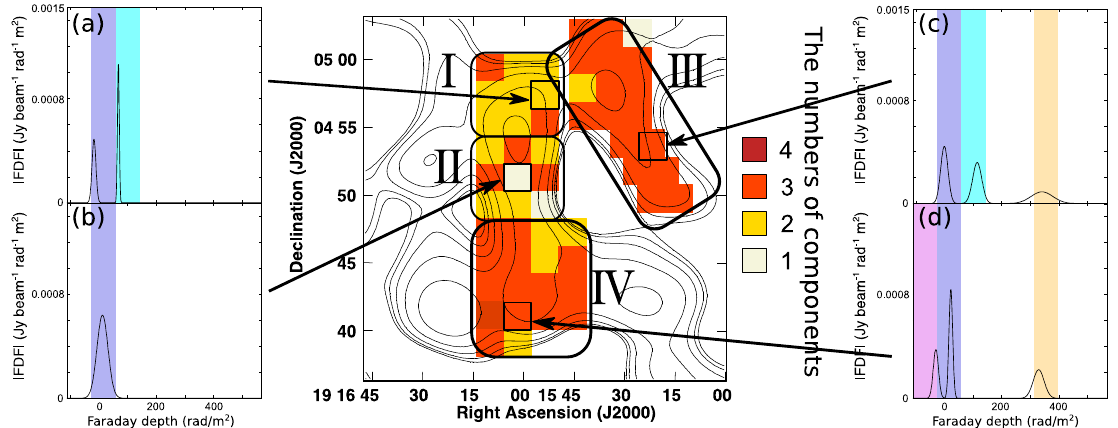
Figure 3. ( Middle panel ) The number of Gaussian components in the selected best-fit model for each pixel, as obtained using QU -fitting. Contours show the total intensity at 3.0 GHz. (Both side plots) the typical best-fit model for each of the structures ( a ) I, ( b ) II, ( c ) III, and ( d ) IV, respectively.